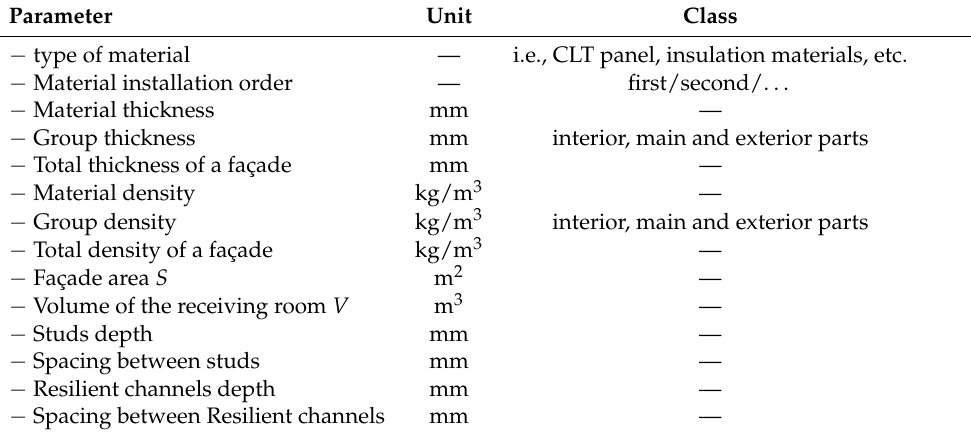
Table 2. Structural variables used to organize the database and employed as inputs for the network